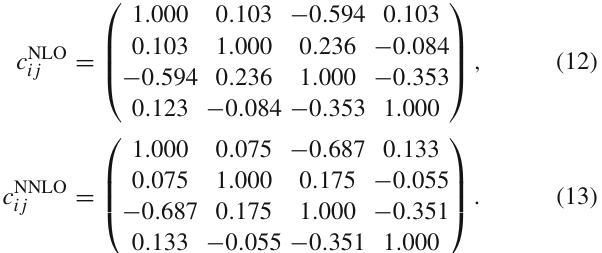
Table 1 The values of the parameters for the deuteron correction factor found in the present global fits